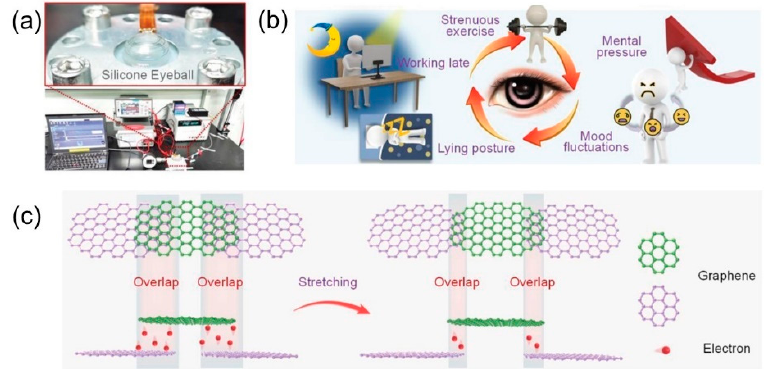
Figure 5. ( a ) Photomicrograph of the test platform configuration using silicon cornea, ( b ) schematic depiction of activities that could induce acute intraocular hypertension and ( c ) schematic illustration of the sensing mechanism of contact lens integrated with SAG film. Reprinted with permission from ref [117] . Copyright 2022 John Wiley and Sons. Table 2. Example studies on nanomaterials-based bioNEMS/MEMS for diagnostic, monitoring and therapeutic applications (selected studies between 2017–2022).